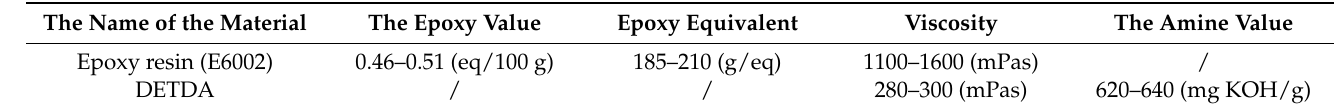
Table 1. Physicochemical characteristics of the matrix material at room